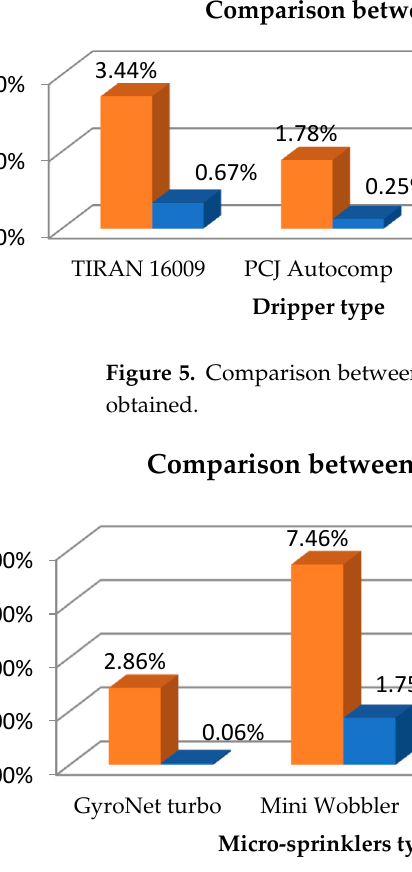
Figure 6. Comparison of micro-sprinklers according to the percentage variation of the coefficients obtained.